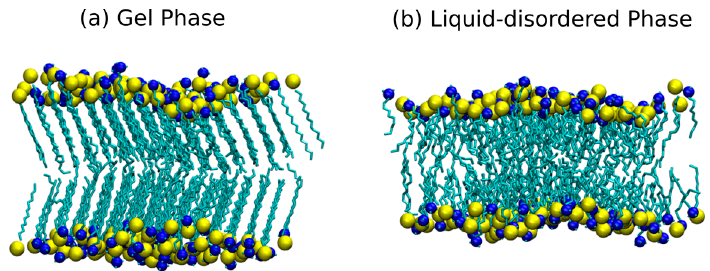
Figure 2. The representative snapshots of an IPA bilayer ( a ) in gel (S) phase or ( b ) in liquid-disordered (Ld) phase. The head group atoms, nitrogen and sulfur, are drawn in blue and yellow, respectively; the alkyl chains are colored in cyan. Graphics were made using visual molecular dynamics (VMD) [24].